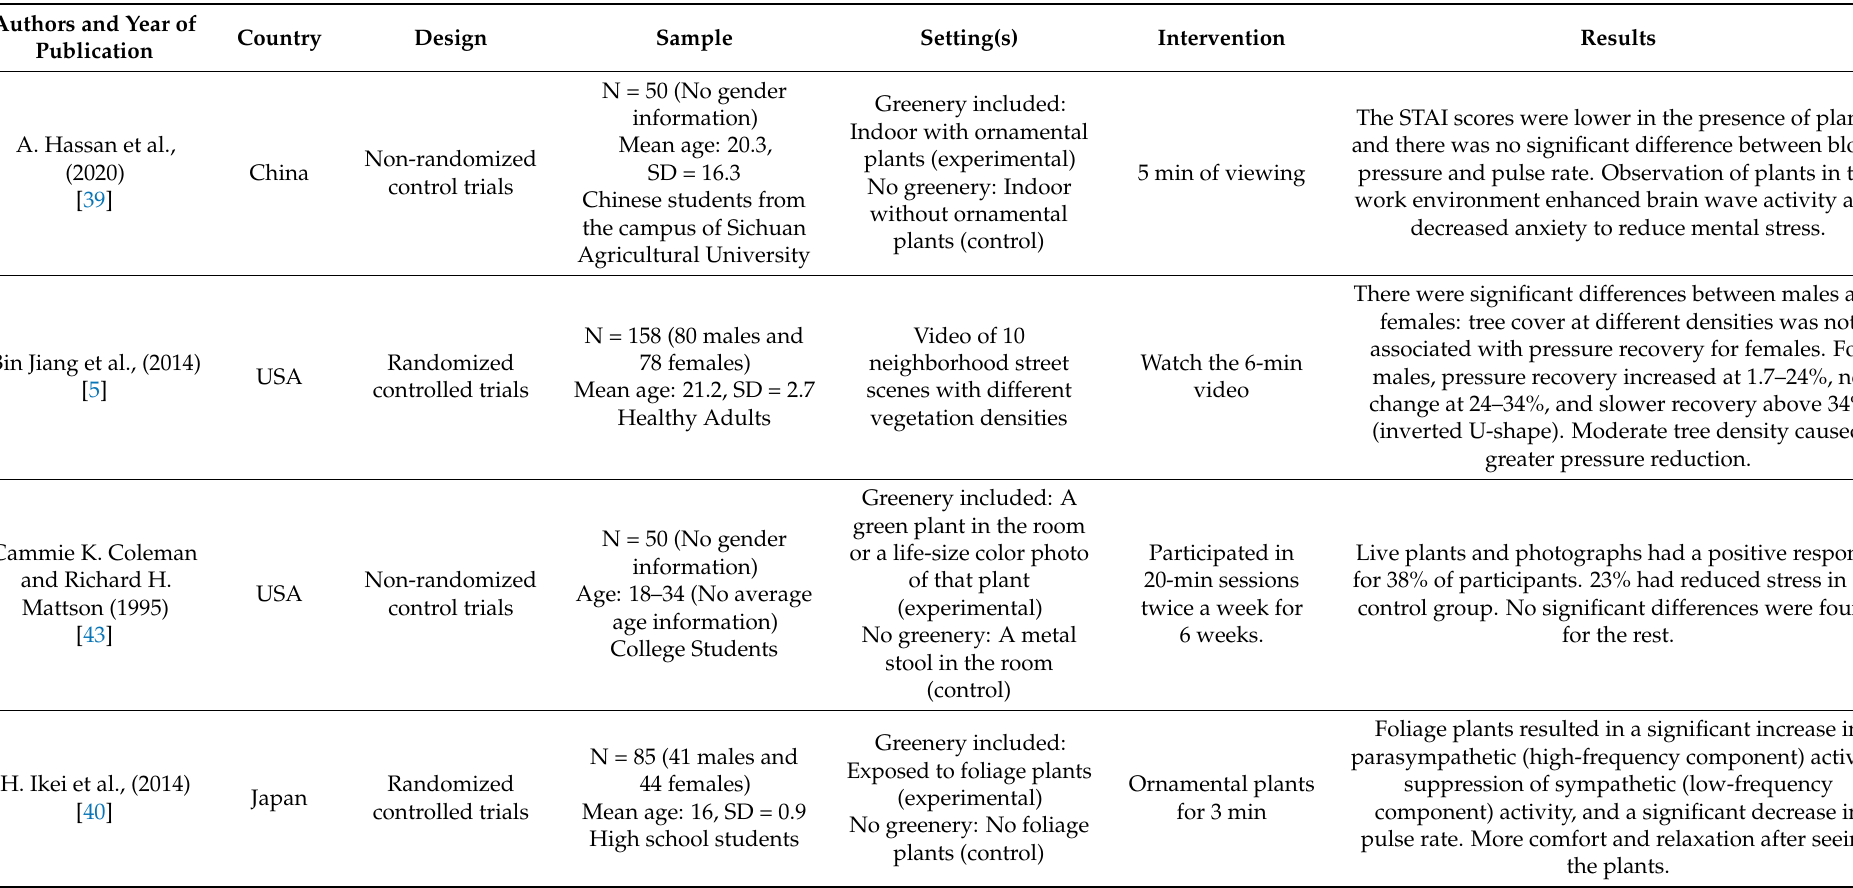
Table 2. Basic characteristics of the studies included in the